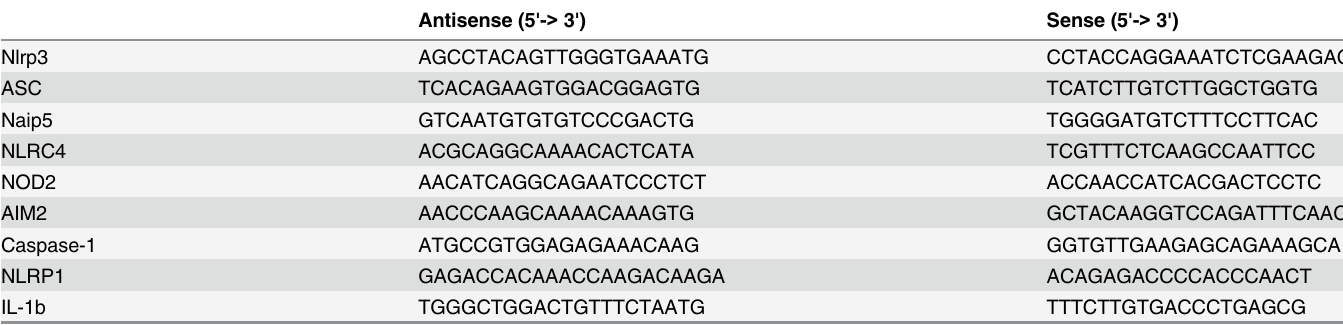
Table 1. Primers used for real-time PCR analysis of mRNA